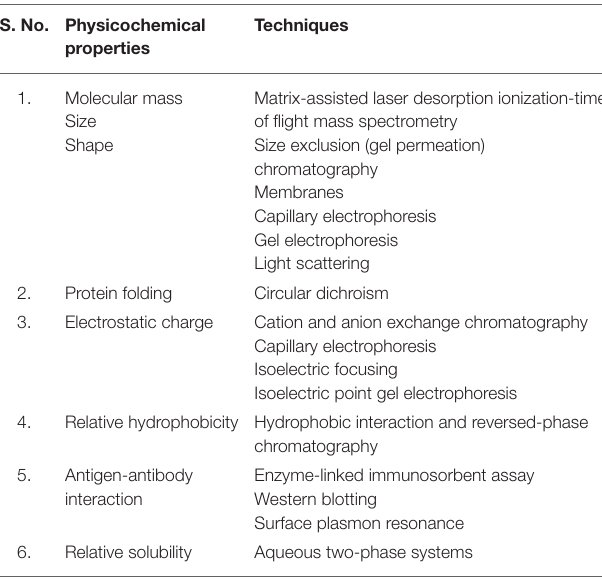
TABLE 1 | Characterization and purification techniques with their physicochemical properties.